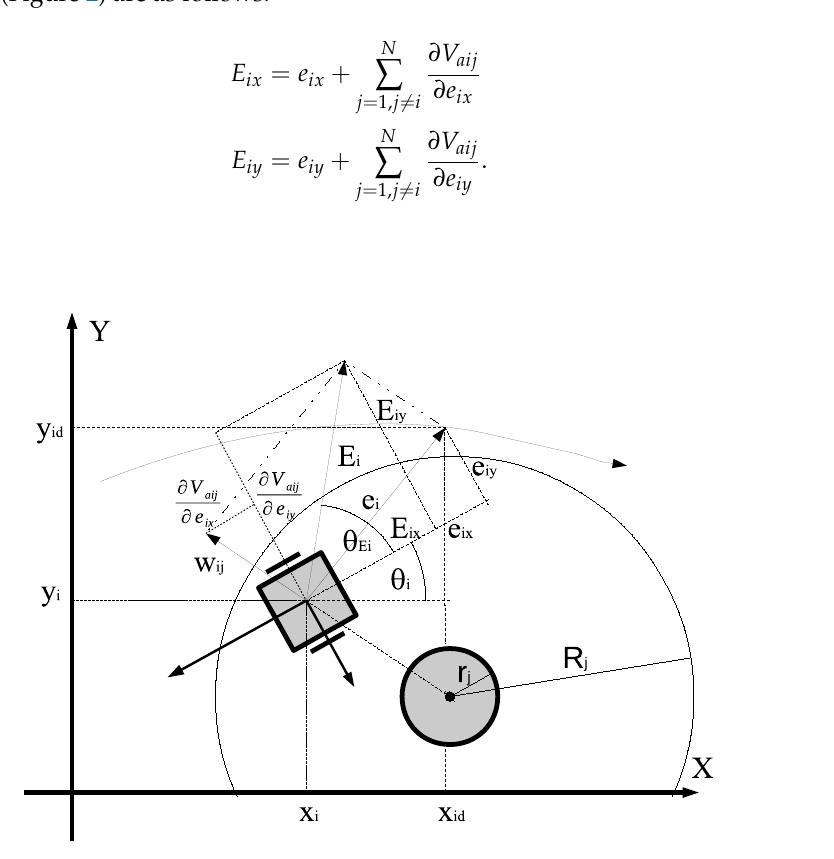
Figure 2. Robot in the environment with an